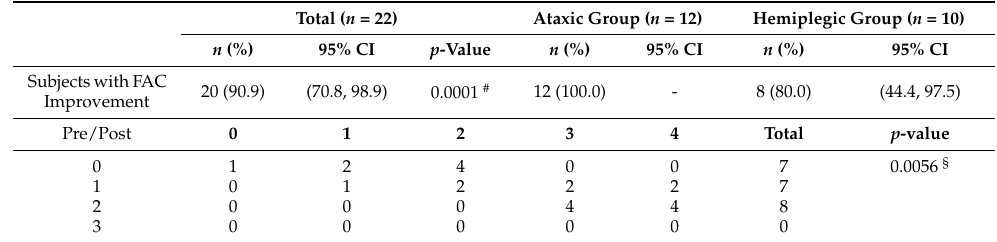
Table 3. Comparative analysis of the FAC within